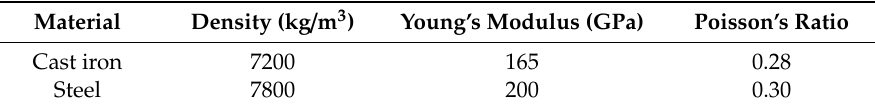
Table 2. Material Table 2. Material parameters.